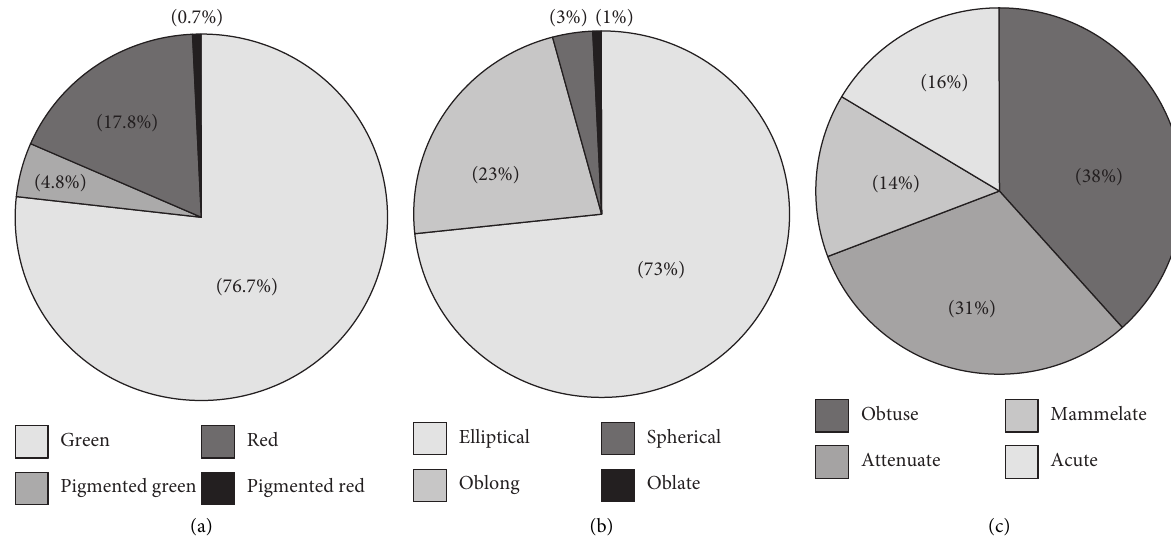
Figure 2: Morphological characteristics of the fruit of 146 fine-flavor native cocoa ecotypes. (a) Color of immature fruit. (b) Fruit shape. (c) Apex shape.